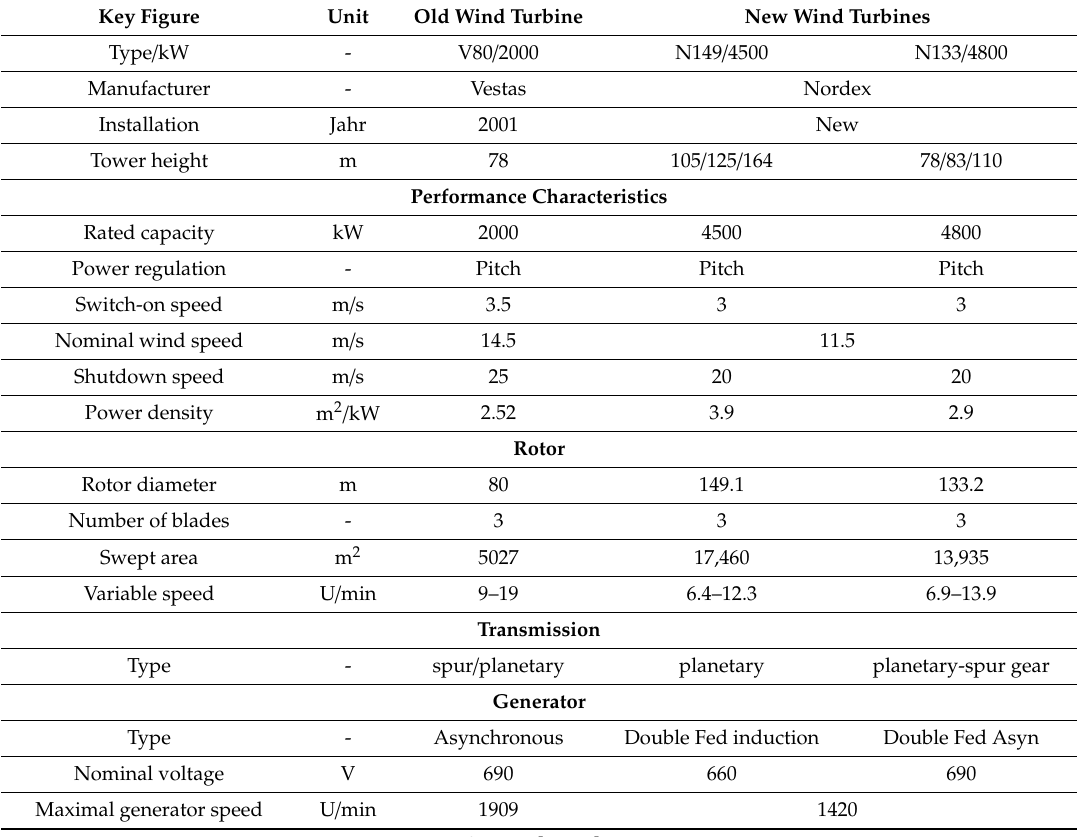
Table 1. Technical data of the old wind turbine (commissioned in 2001) and the new wind